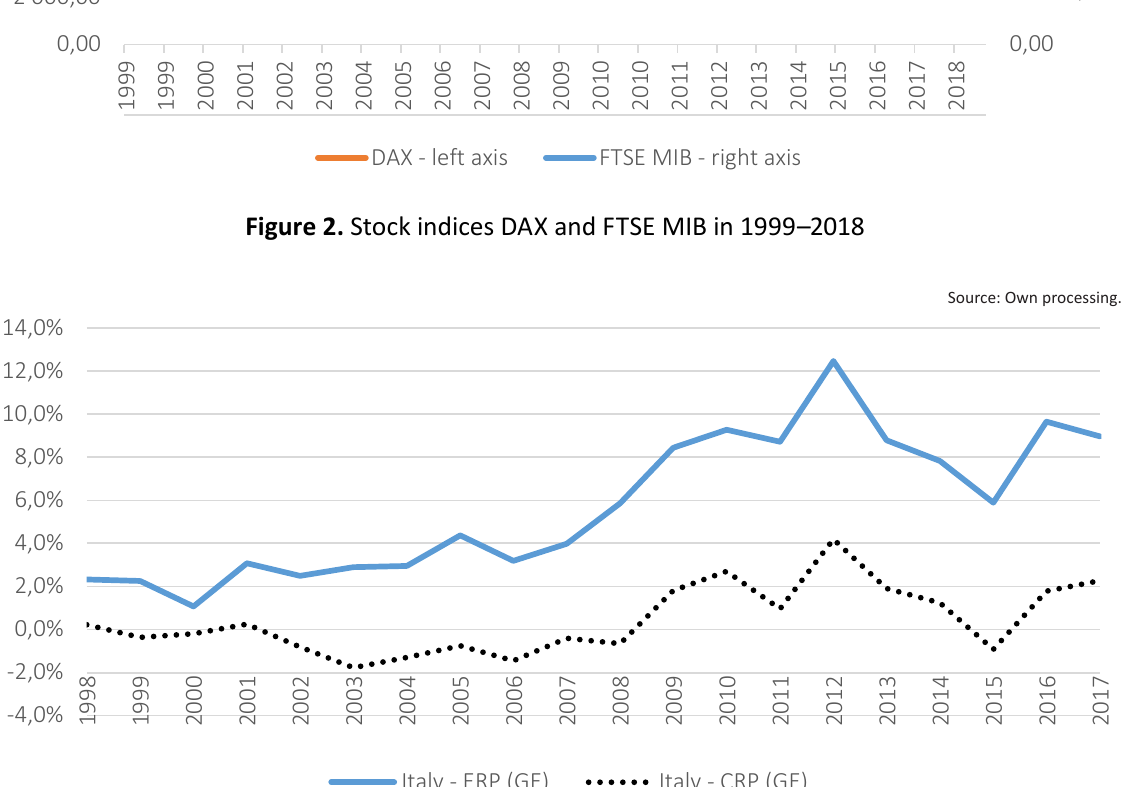
Figure 3. Equity risk premium and country risk premium of Italy in 1998–2017